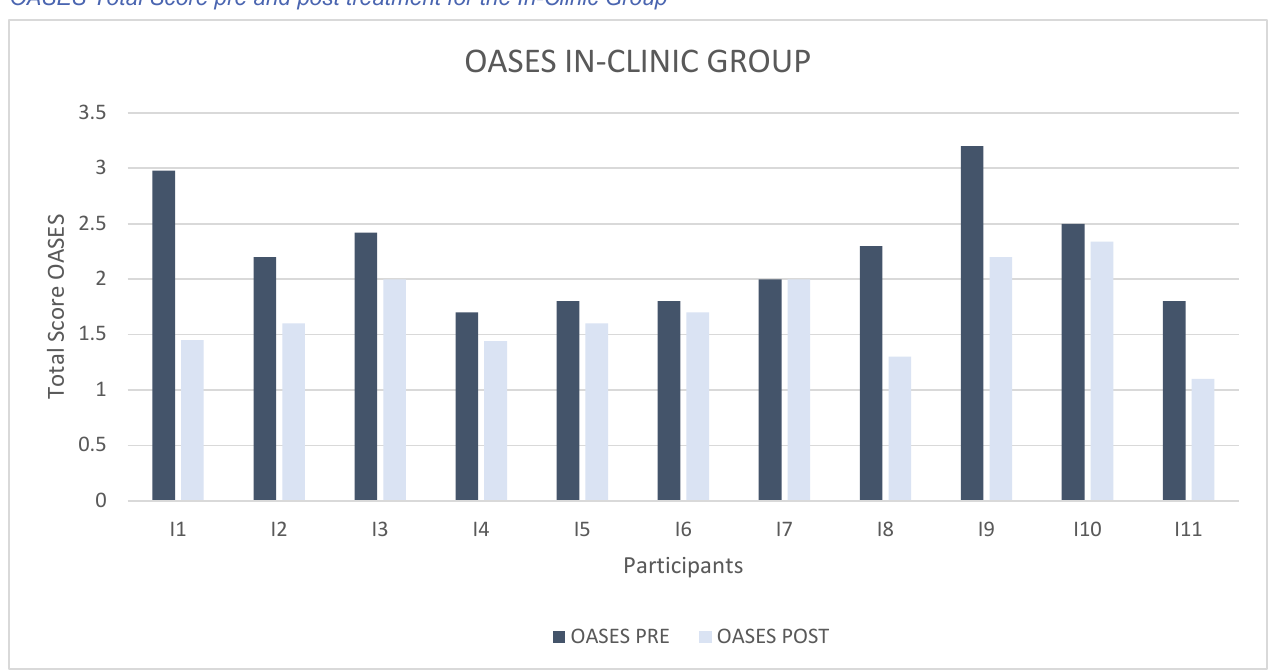
Table 4 summarizes the scores obtained by individual participants in the In-Clinic group on the SSI-4 and OASES tests before and after treatment.